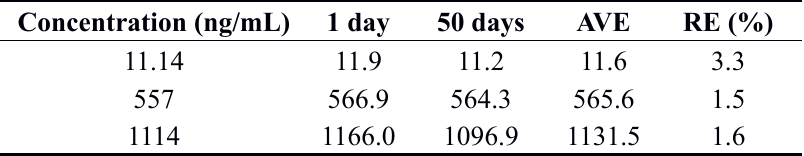
Table 11. Long-term stability storage at − 20 °C for 50 days ( n = 6).